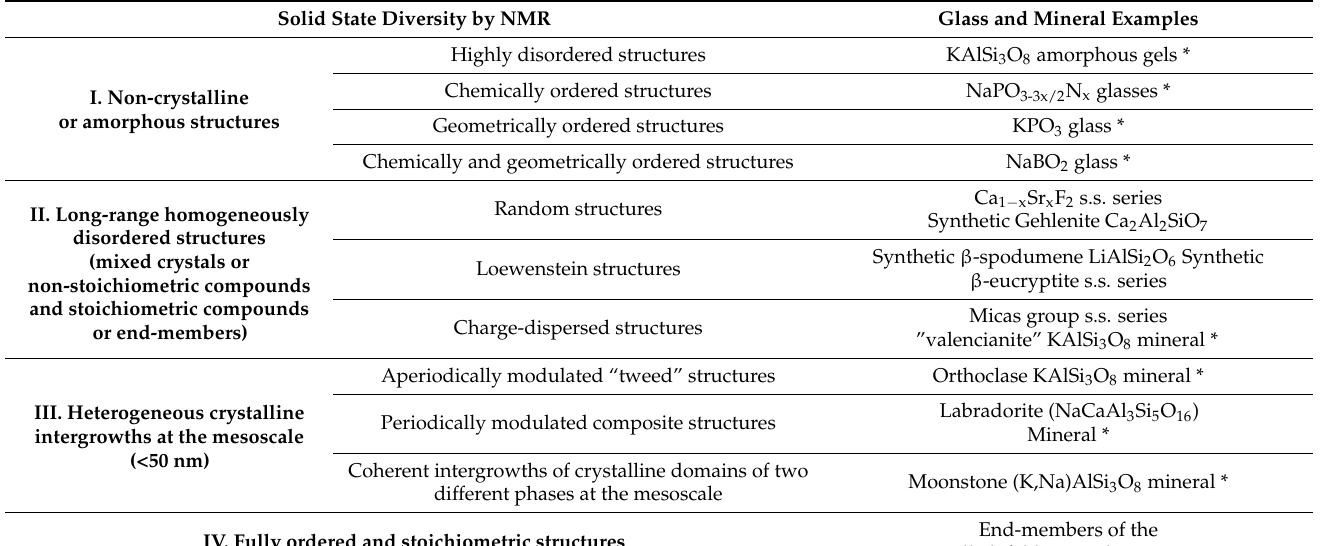
Table 1. Diversity of order–disorder states found in glasses and